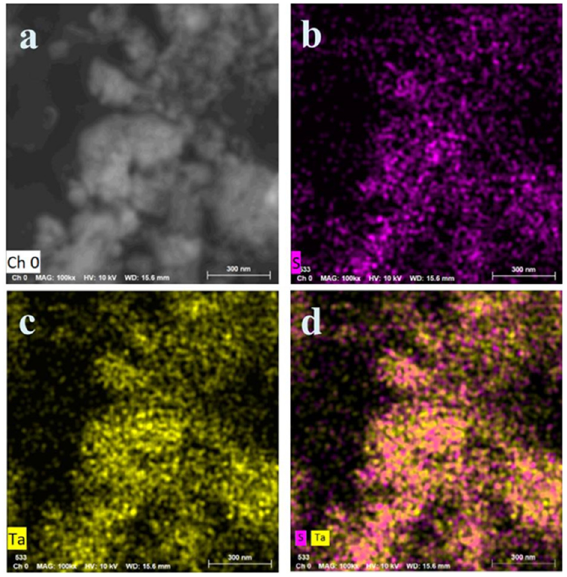
Figure 5. Elemental mapping characterizations of superstructure TaS 2 nanosheets by STEM EDS. ( a ) STEM image of TaS 2 nanosheets, similarly acquired with ( b – d ) Ta, S, and Ta + S EDS elemental maps.